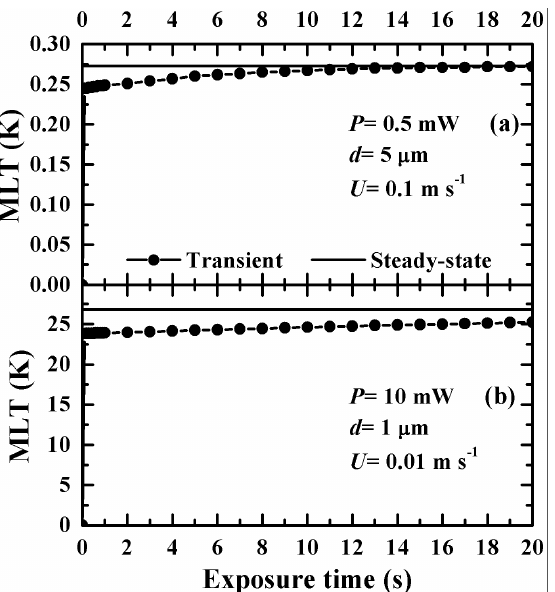
Figure 7. Transient simulation results: MLT v.s. the exposure time under two conditions: ( a ) P = 0.5 mW, d = 5 μm , U = 0.1 m·s − 1 and ( b ) P = 10 mW, d = 1 μm , U = 0.01 m·s − 1